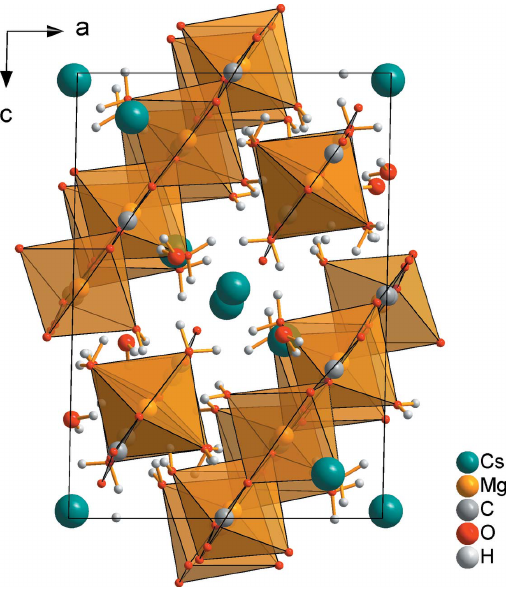
Figure 5 Coordination sphere of the Cs1 cation, with all atoms drawn as spheres of arbitrary radii (oxygen atoms not coordinating to Cs with half of the size of other O atoms). [Symmetry codes: (i) x (cid:4) 1, y , z ; (ii) x (cid:4) 1 , (cid:4) y + 3 , z + 1 ; 2 2 2 (iii) (cid:4) x + 2, (cid:4) y + 1, (cid:4) z ; (iv) x (cid:4) 1 , (cid:4) y + 3 , z (cid:4) 1 ; (v) x + 1 , (cid:4) y + 3 , z (cid:4) 1 ; (vi) 2 2 2 2 2 2 (cid:4) x + 3 , y + 1 , (cid:4) z + 1 2 2 2